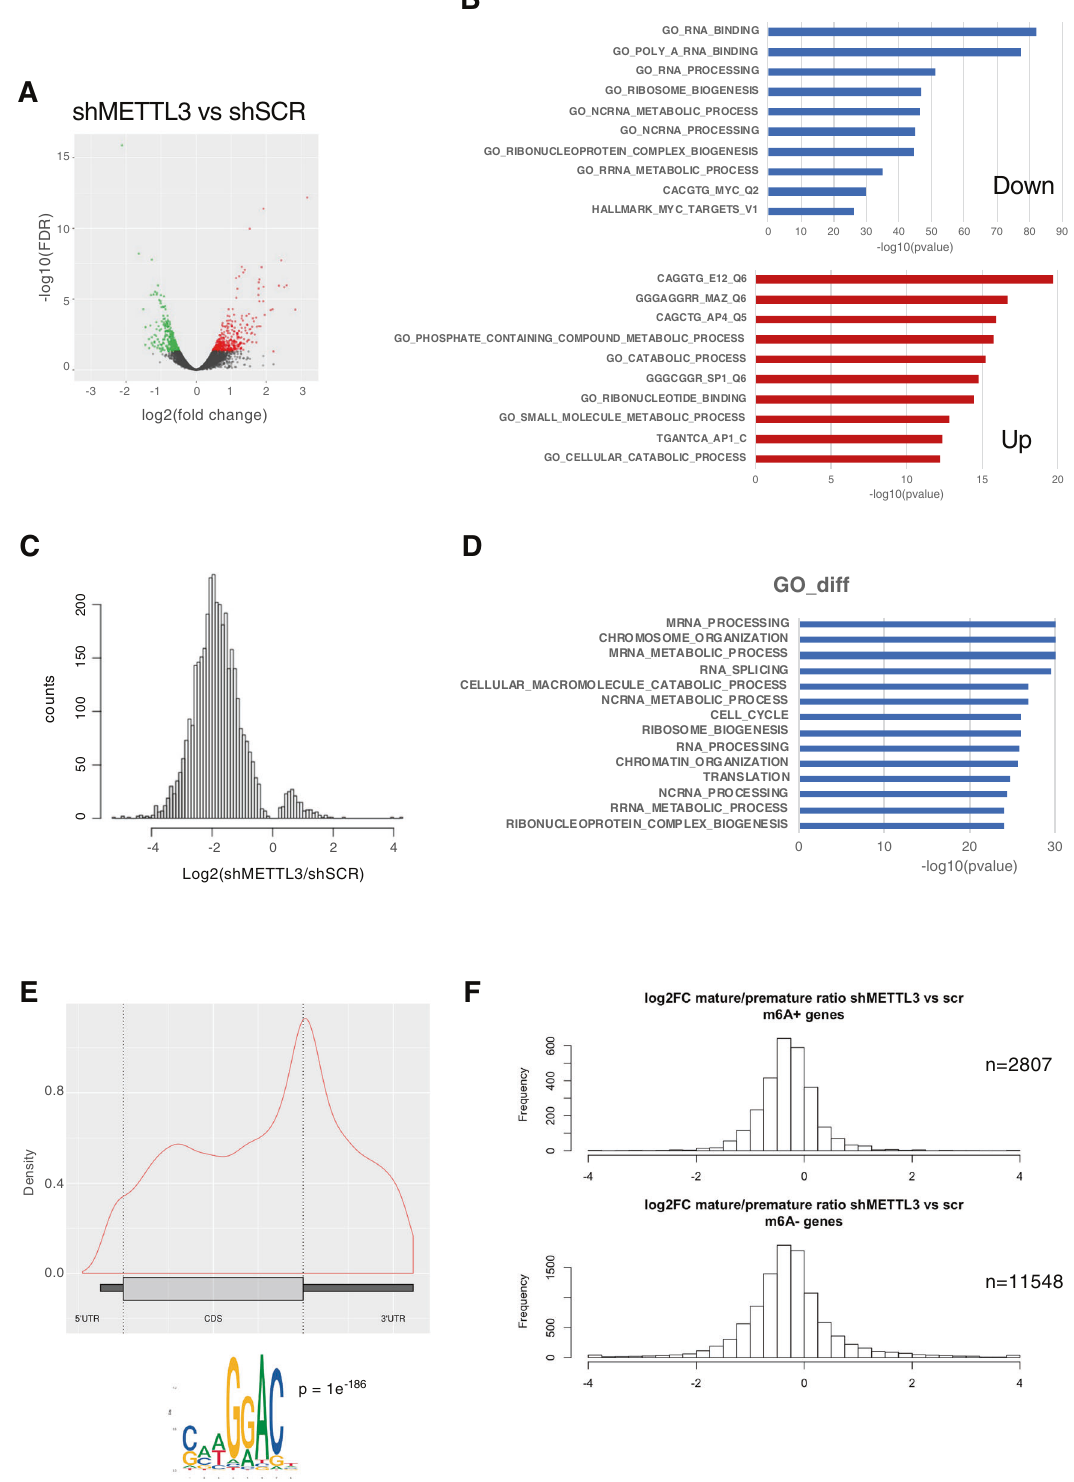
signi fi cantly upregulated in shMETTL3 vs shSCR (Fig. 4A, Supple- mental Table S1). Biological process ontology of signi fi cantly differentially expressed genes identi fi ed several pathways including RNA binding, RNA processing and ribosome biogenesis (Fig. 4B). Thus, these data indicate that genes involved in RNA